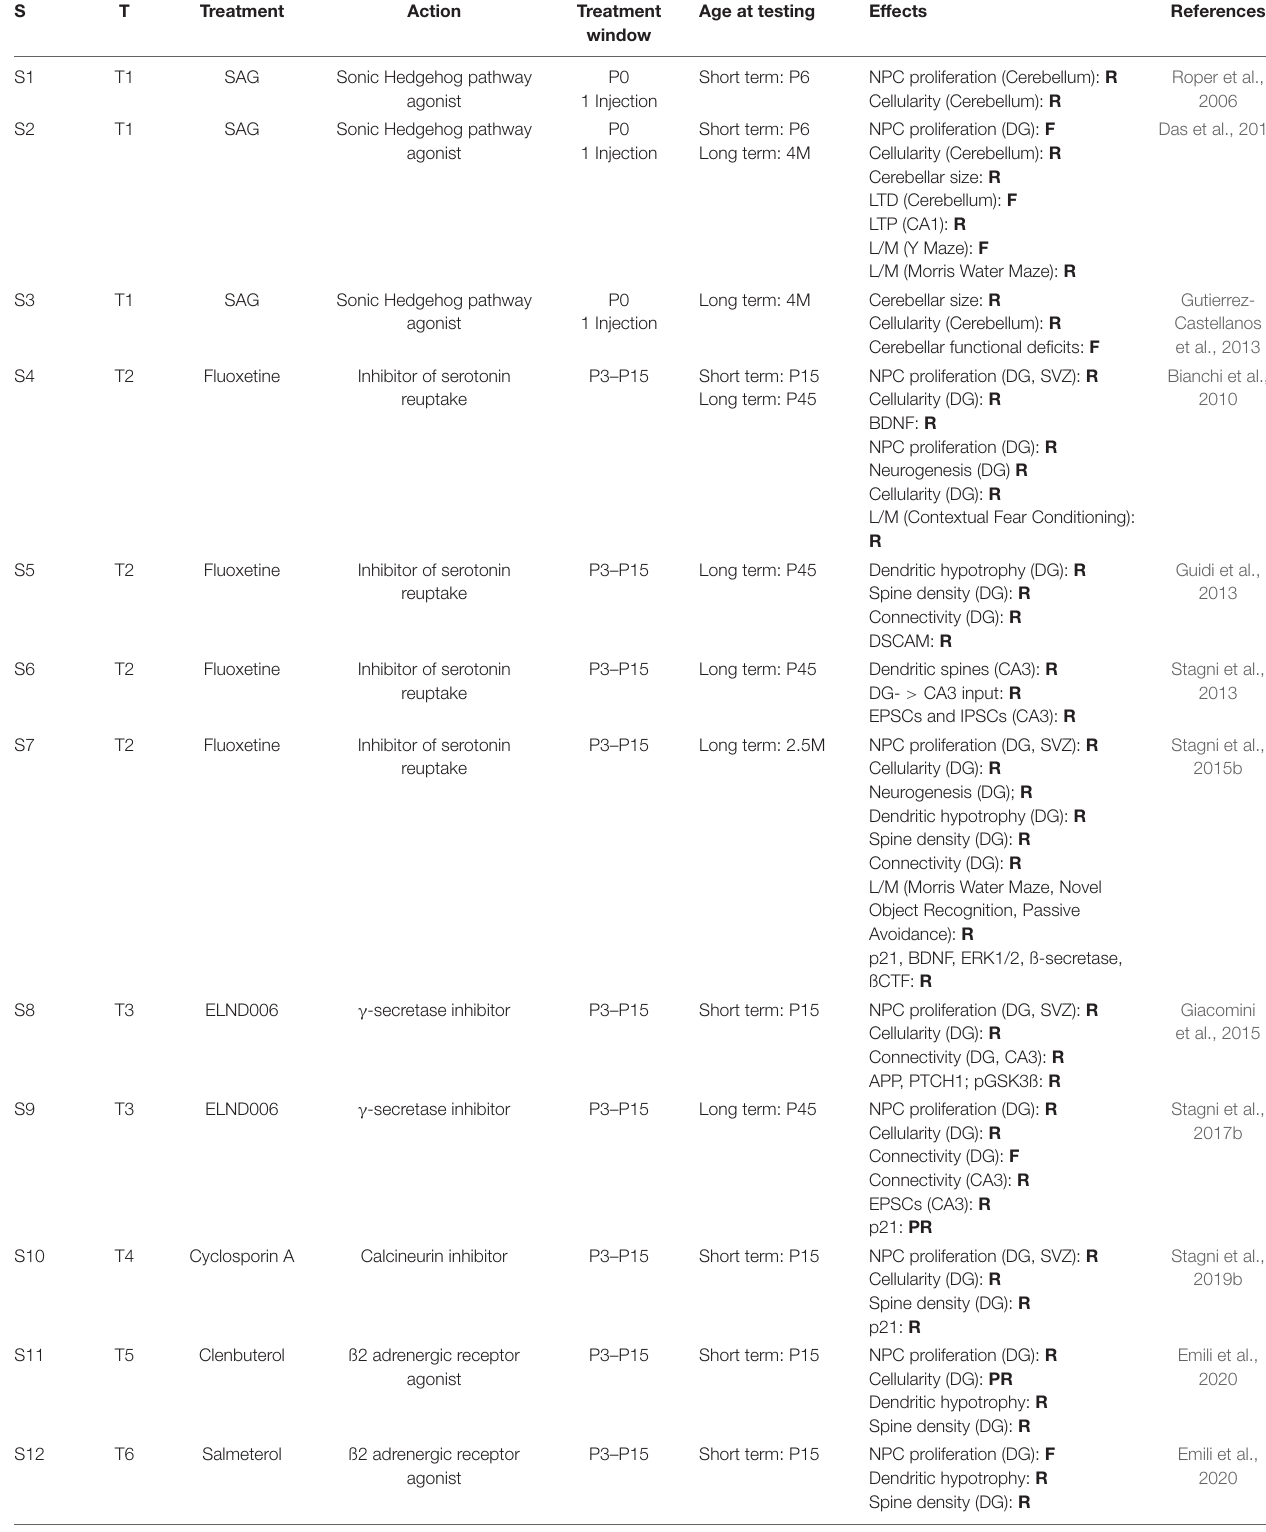
TABLE 2 | Treatments administered at neonatal life stages in the Ts65Dn